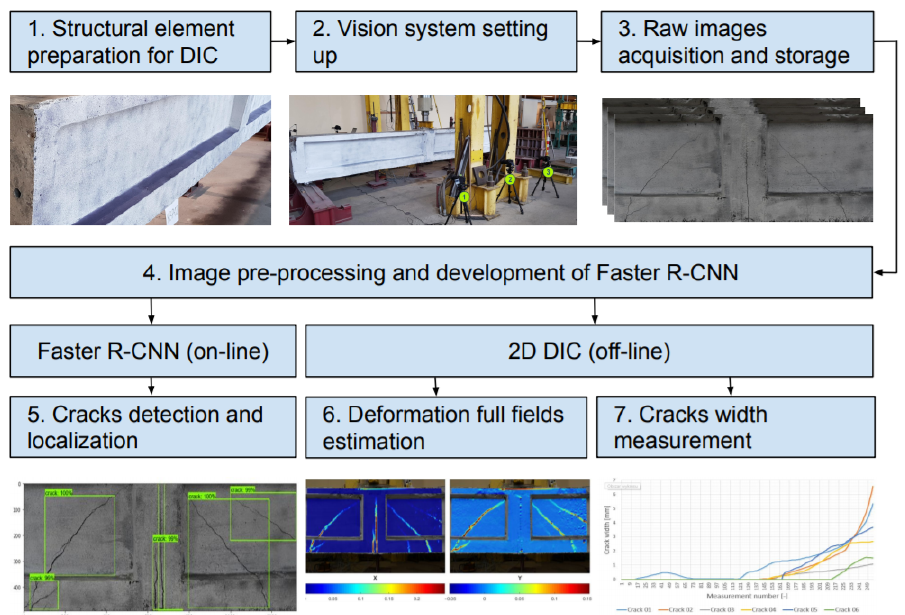
Figure 1. Flowchart for assessment of concrete surface cracks using Faster R-CNN and 2D DIC.